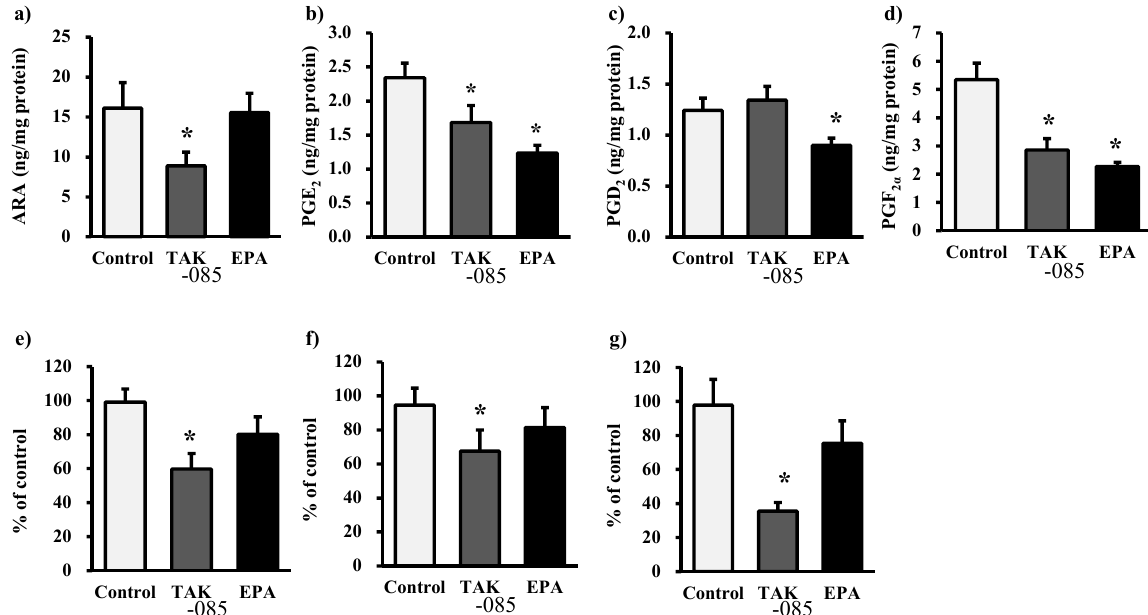
Figure 3. Renal levels of ARA-derived eicosanoids. ( a ) Nonesterified ARA, ( b ) PGE , ( d ) PGF , ( e ) 5-HETE, ( f ) 12-HETE, and ( g ) 15-HETE. Values are presented as ( c ) PGD 2 2 α mean ± SE (n = 10–11). Statistical analysis was performed by one-way ANOVA followed by Dunnett’s test. * P < 0.05 vs. control group.